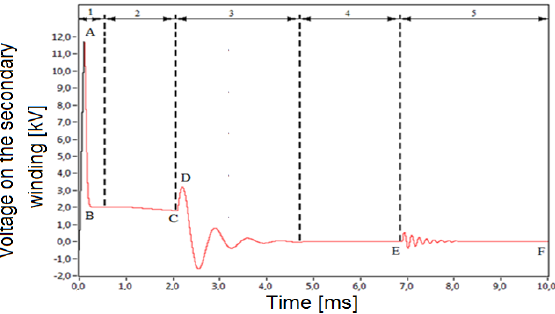
Fig. 2. The ignition signal on the secondary side is made with LabView